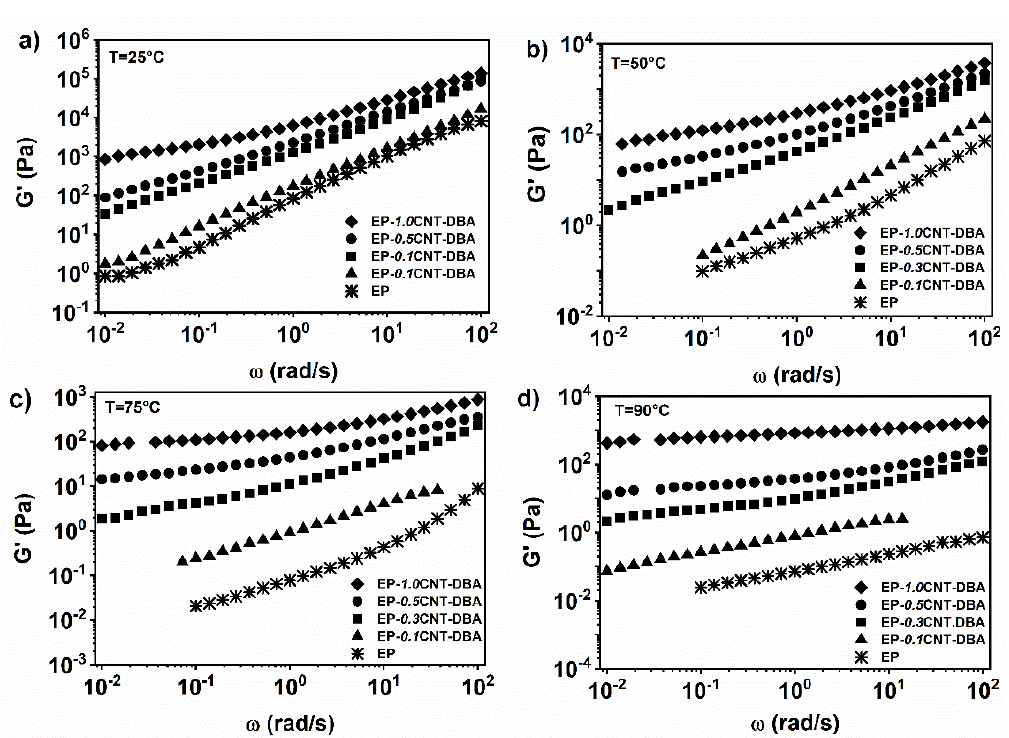
Figure 9. Storage modulus (G’) vs. frequency ( ω ) for EP-DBA with different concentrations of MWCNTs at: ( a ) T = 25 °C; ( b ) T = 50 °C; ( c ) T = 75 °C; ( d ) T = 90 °C.